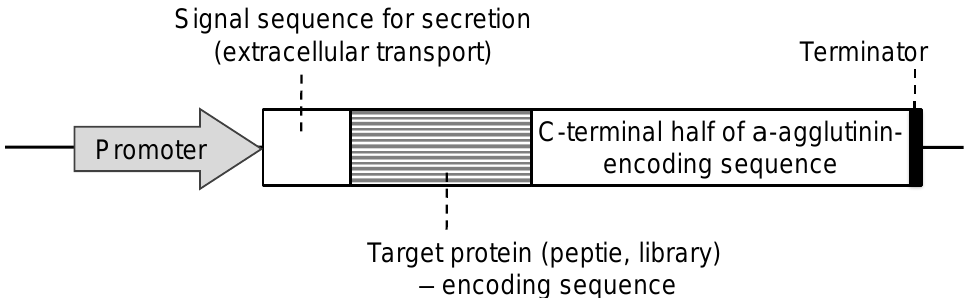
Figure 2. Fusion gene construction for cell-surface display of metal-binding protein and peptide on yeast cell surface. Secretion signal sequence is necessary for extracellular transport of a fusion pro- tein.